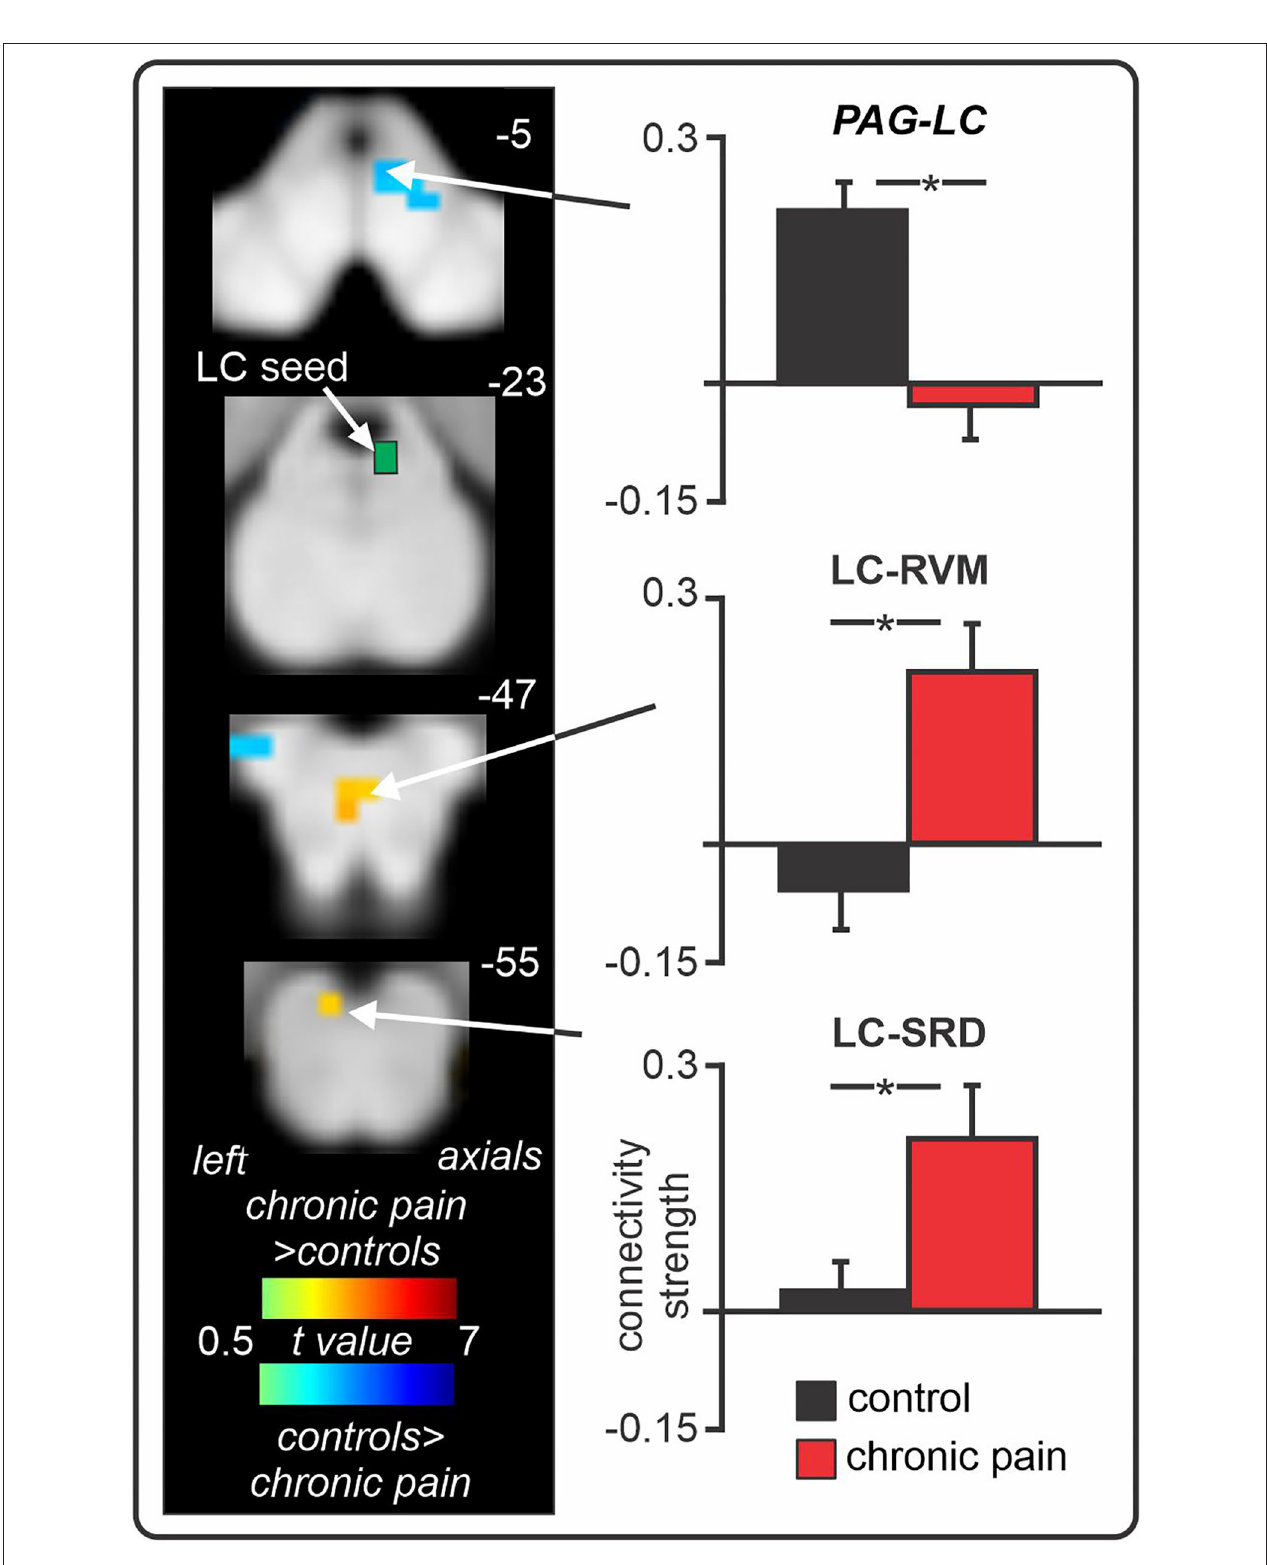
FIGURE 5 | Changes in locus coeruleus (LC) fMRI signal coupling in individuals with chronic orofacial neuropathic pain. Compared to pain-free controls, chronic pain patients show enhanced positive LC signal coupling with the rostral ventromedial medulla (RVM) and subnucleus reticularis dorsalis (SRD). Furthermore, individuals with chronic pain display near-zero signal coupling between the LC and periaqueductal grey (PAG). *significant between-groups difference determined in a voxel-by-voxel analysis. Figure modified with permission from Mills et al. (32).